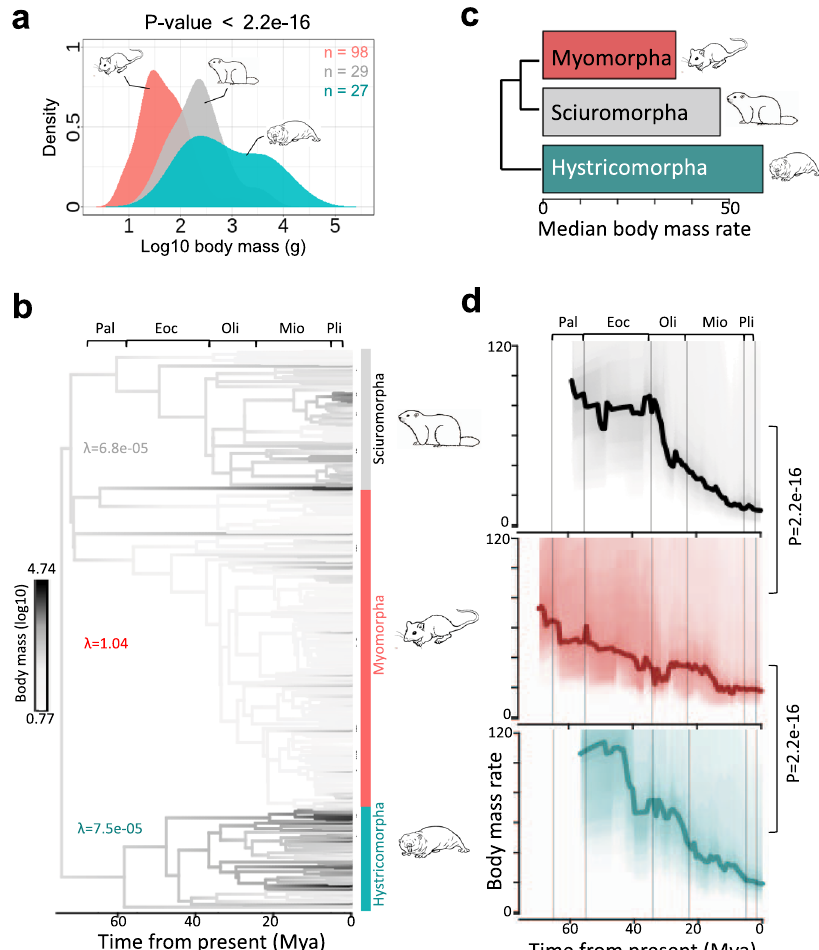
Fig. 6 Rate of body mass evolution in rodent clades. a Distribution of log10 body mass of myo-, hystrico- and sciuromorphs. P value was calculated using Kruskal – Wallis test. b Ancestral reconstruction of body mass across phylogenetic tree of 312 rodent species. Pagel ’ s λ values were calculated using ‘ phyloSig ’ function of ‘ phytools ’ . c Median rate of body mass evolution in myo-, hystrico- and sciuromorphs. d Rate of body mass evolution in myo-, hystrico- and sciruomorphs as a function time from the present. Body mass rates were calculated using the BAMM model. P values were calculated using two-sided Mann – Whitney U